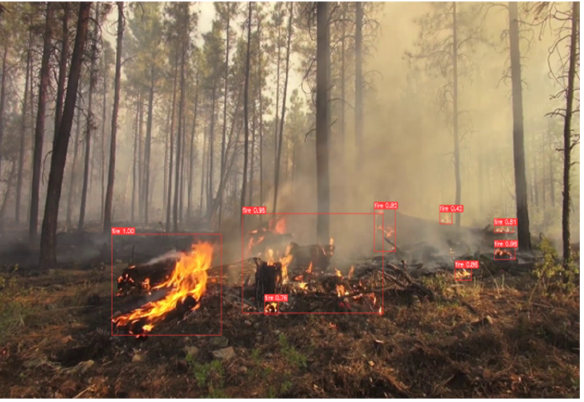
Figure 11. Detection result of small-target forest fires and large-target forest fires using STPM_SAHI.